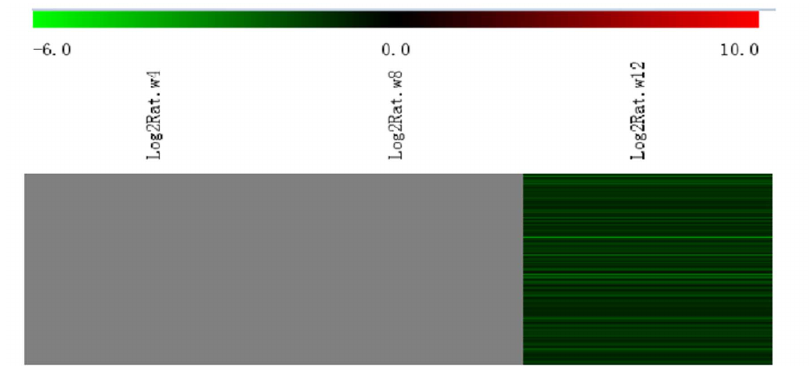
Figure 9. The Heat Map and the list of genes which were down-regulated at the late stage (12 weeks of age). There were a total of 486 genes in the list.